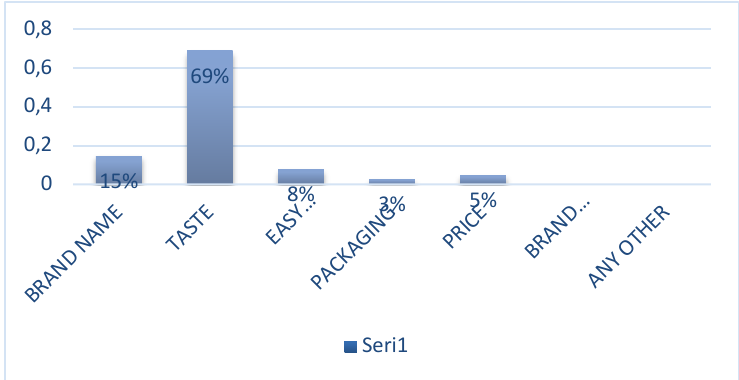
Figure 6: Answers on “About Cola drink what do you like the